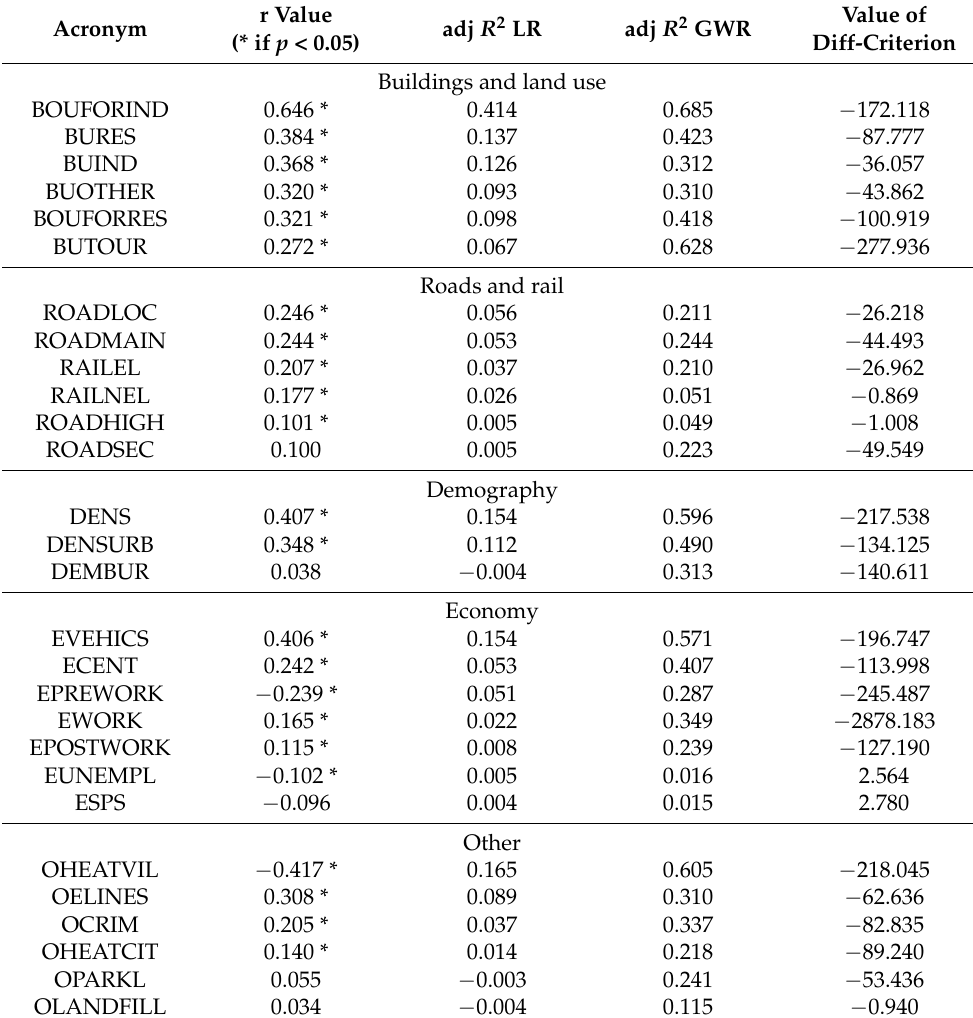
Table 2. Results of statistical analysis for the relationship of single independent variables with forest fires for the 2007–2017